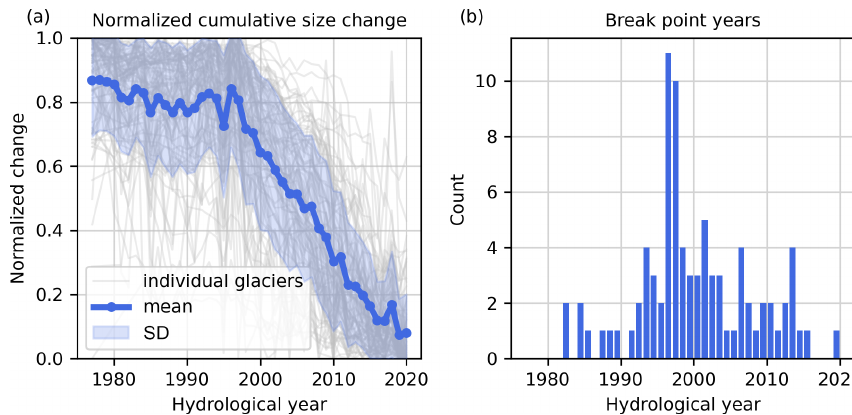
Figure 5. Break-point analysis to identify the onset of increased terminus retreat rates. (a) Glacier cumulative area change is normalized such that for each glacier the greatest observed extent is 1 and the smallest observed extent is 0 so that glaciers of all sizes are placed on a common scale. Each glacier’s cumulative change is then approximated as a two-segment piecewise linear function, and for cases where the piecewise linear function is statistically better than a linear regression, we compute (b) a histogram of the break-point year between the two